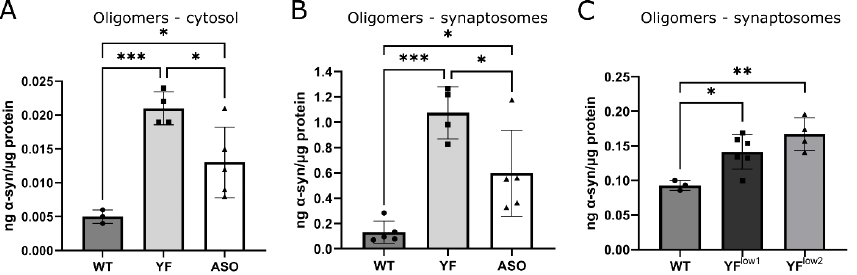
Figure 4. α -synuclein oligomer levels are increased in YF mice. ( A ). Quantitation of oligomers measured by ELISA showing that YF mice ( n = 4) have significant higher amounts of soluble oligomers compared to age-matched ASO ( n = 5) and wildtype (WT) mice ( n = 3) in the cytosol. ( B ). The